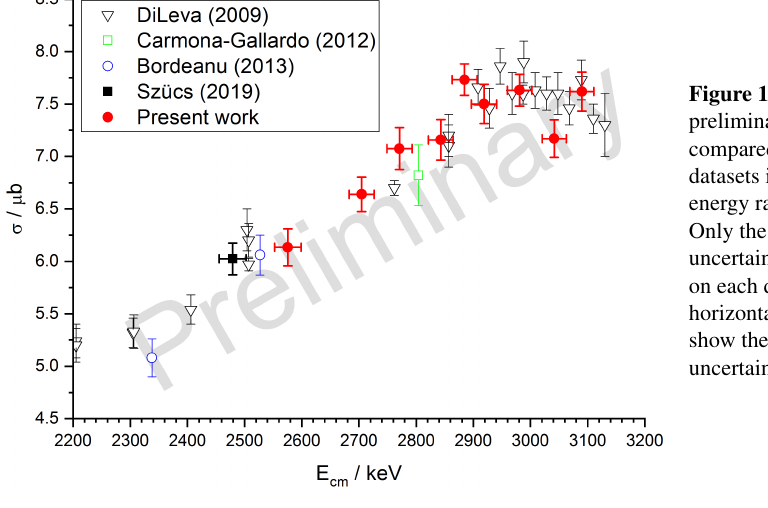
Figure 1. The new preliminary data is compared with literature datasets in a similar energy range [3, 5, 6, 8]. Only the statistical uncertainties are plotted on each datapoint. The horizontal error bars show the beam energy uncertainty in the